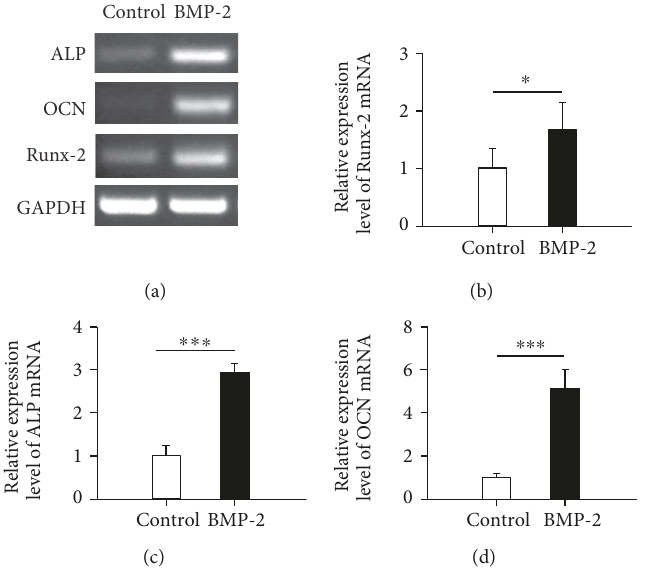
Figure 1: Identi fi cation of primary calvarial osteoblasts. The primary osteoblasts were isolated from calvaria of neonatal Sprague-Dawly rats. (a) The gene expression levels of alkaline phosphatase (ALP), osteocalcin (OCN), and Runx-2 were detected by RT-PCR after the cells were cultured in the absence or presence of recombinant human bone morphogenetic protein-2 (BMP-2) (300ng/ml); GAPDH was used as a gel loading control. (b, c, d) The gene expression levels of ALP, OCN, and Runx-2 were analyzed by quantitative real-time RT-PCR. Compared with the cells without BMP-2 stimulation: ∗ p < 0 05 , ∗∗∗ p < 0 001